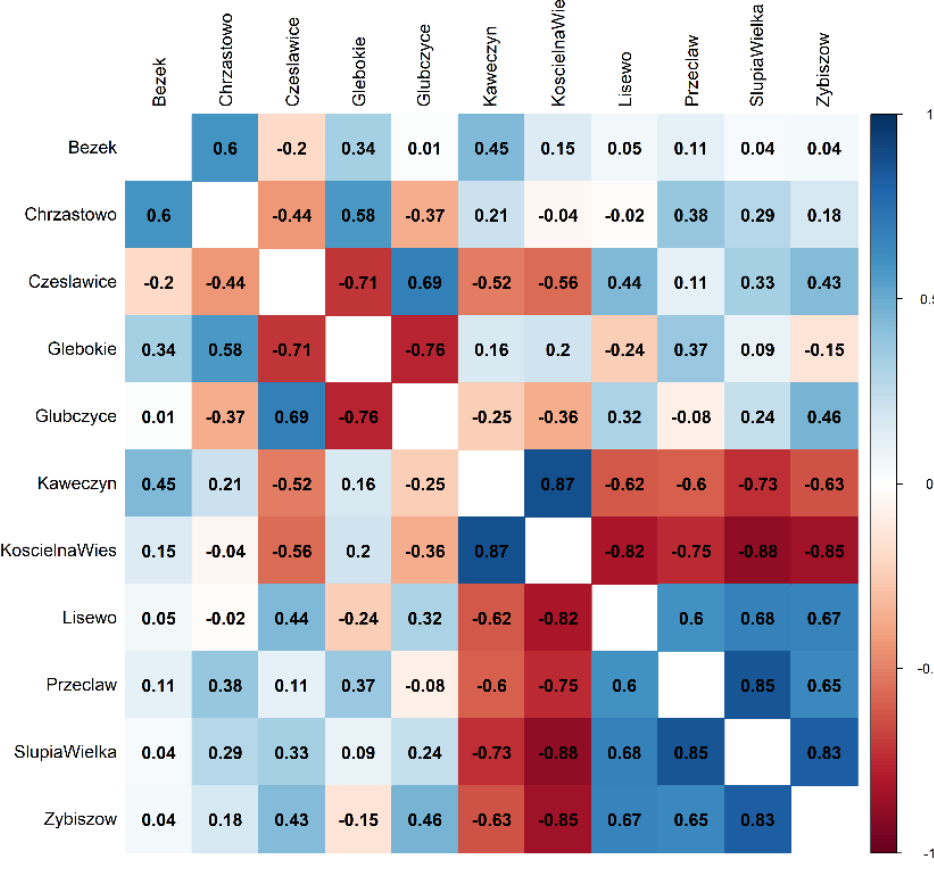
Figure 2. Spearman rank correlation coefficients of cultivars ’ white sugar yield between tested trial locations.